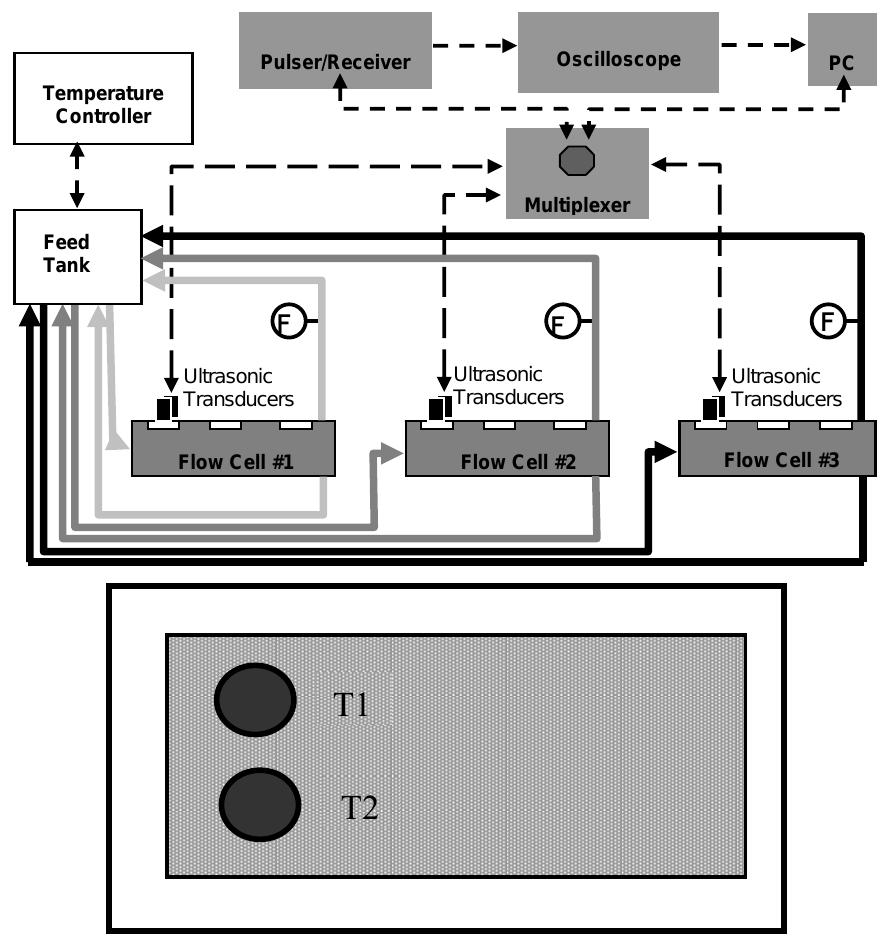
Figure 1. TOP: schematic of microfiltration (MF) cross-flow cell system with integrated instrumentation; BOTTOM: Top view of the bottom plate of the cross-flow cell showing the location of the two ultrasonic transducers (T1 and T2) and flow-sensors